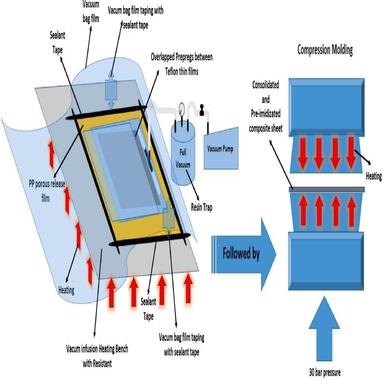
The detailed process scheme of composite manufacturing.